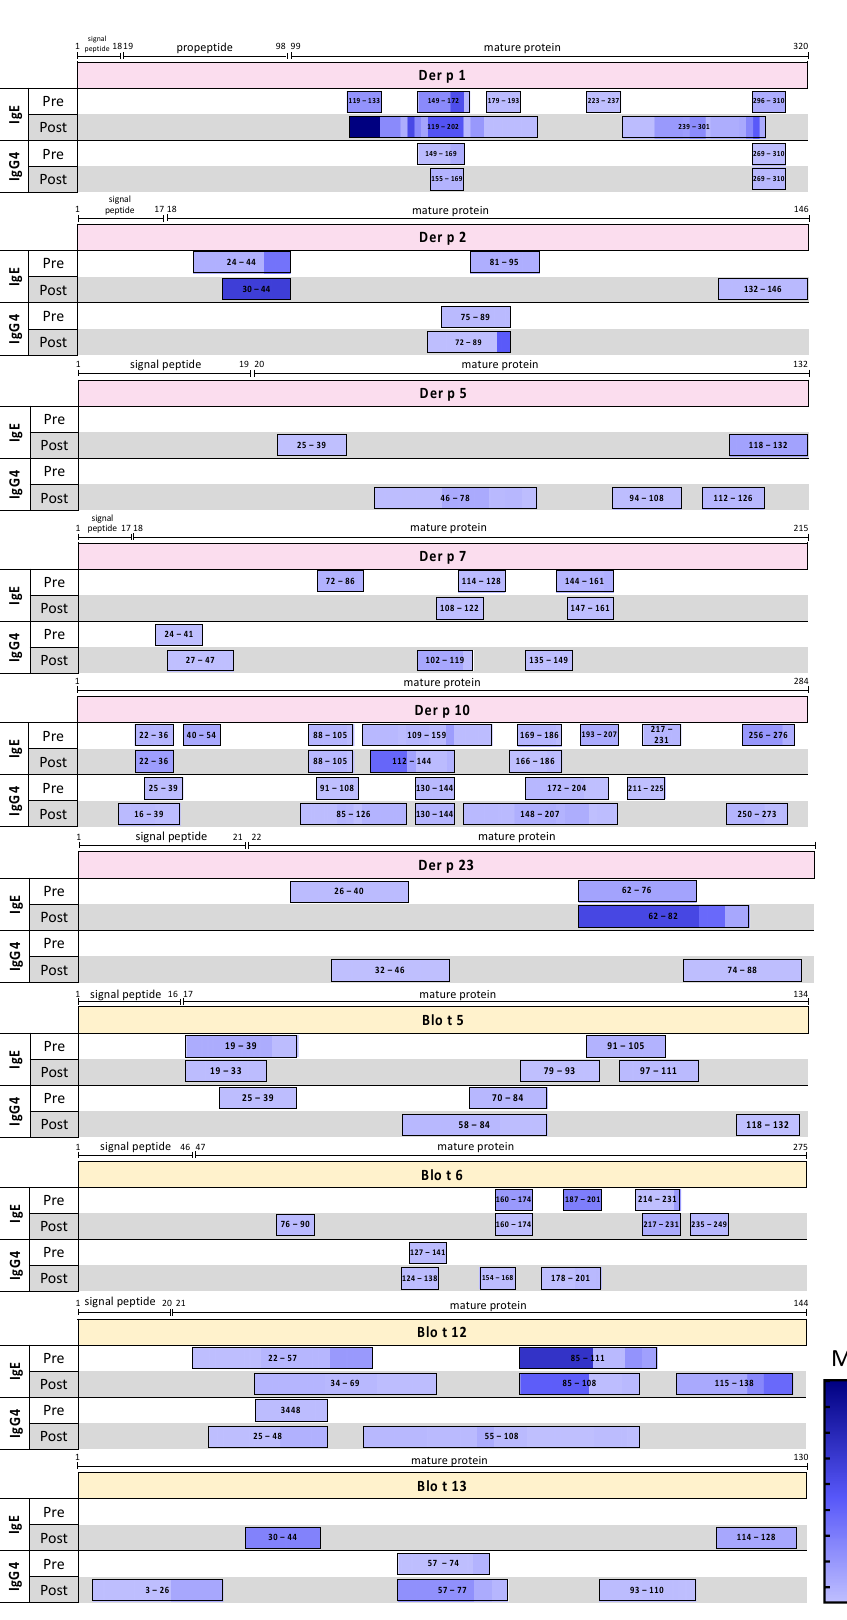
Figure 3. Epitopes’ localization and amplitude of responses for IgE and IgG4 pre- and post-1-year SLIT. Peptides’ positions were assigned considering the whole sequence of protein. MFI = Median Fluorescence